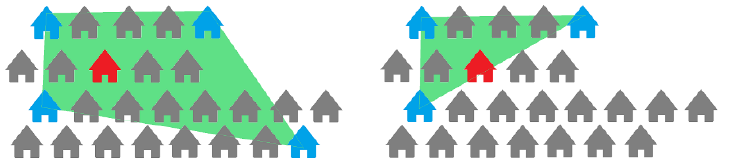
Figure 4. Change in coverage of a subject after applying Filter